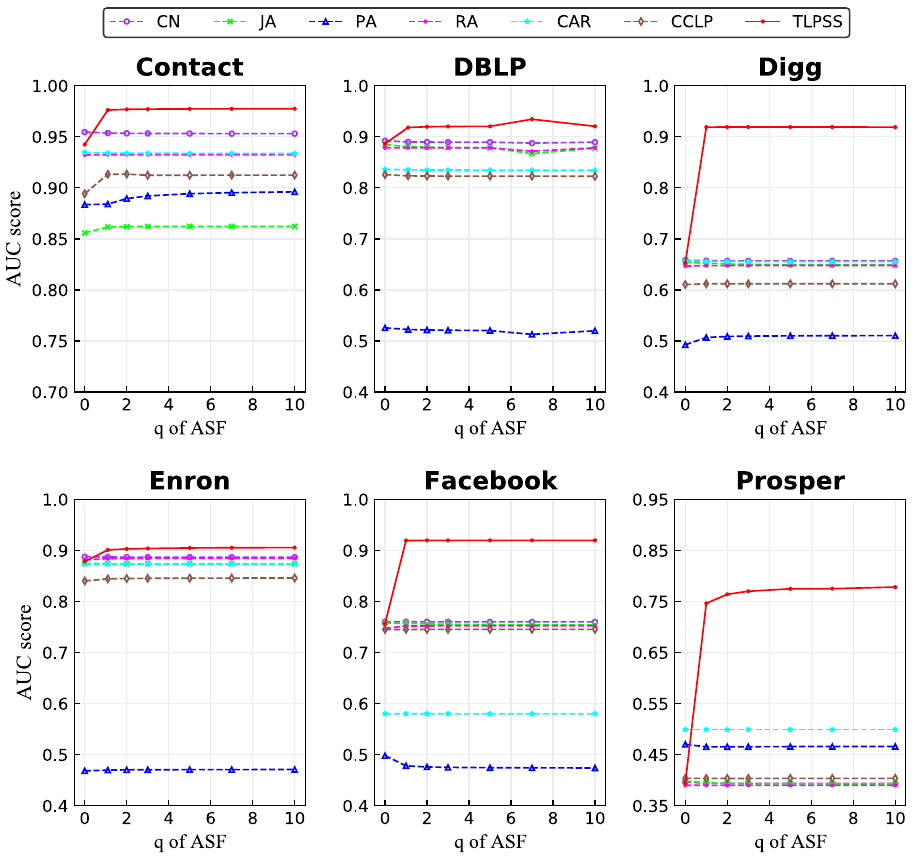
Figure 7. Performance comparison of varying parameter q in different dynamic networks. The AUC value of the TLPSS model includes rising stage and stable stage. Explosive rising stage illustrates the effectiveness of latent edge composed of 2-simplices